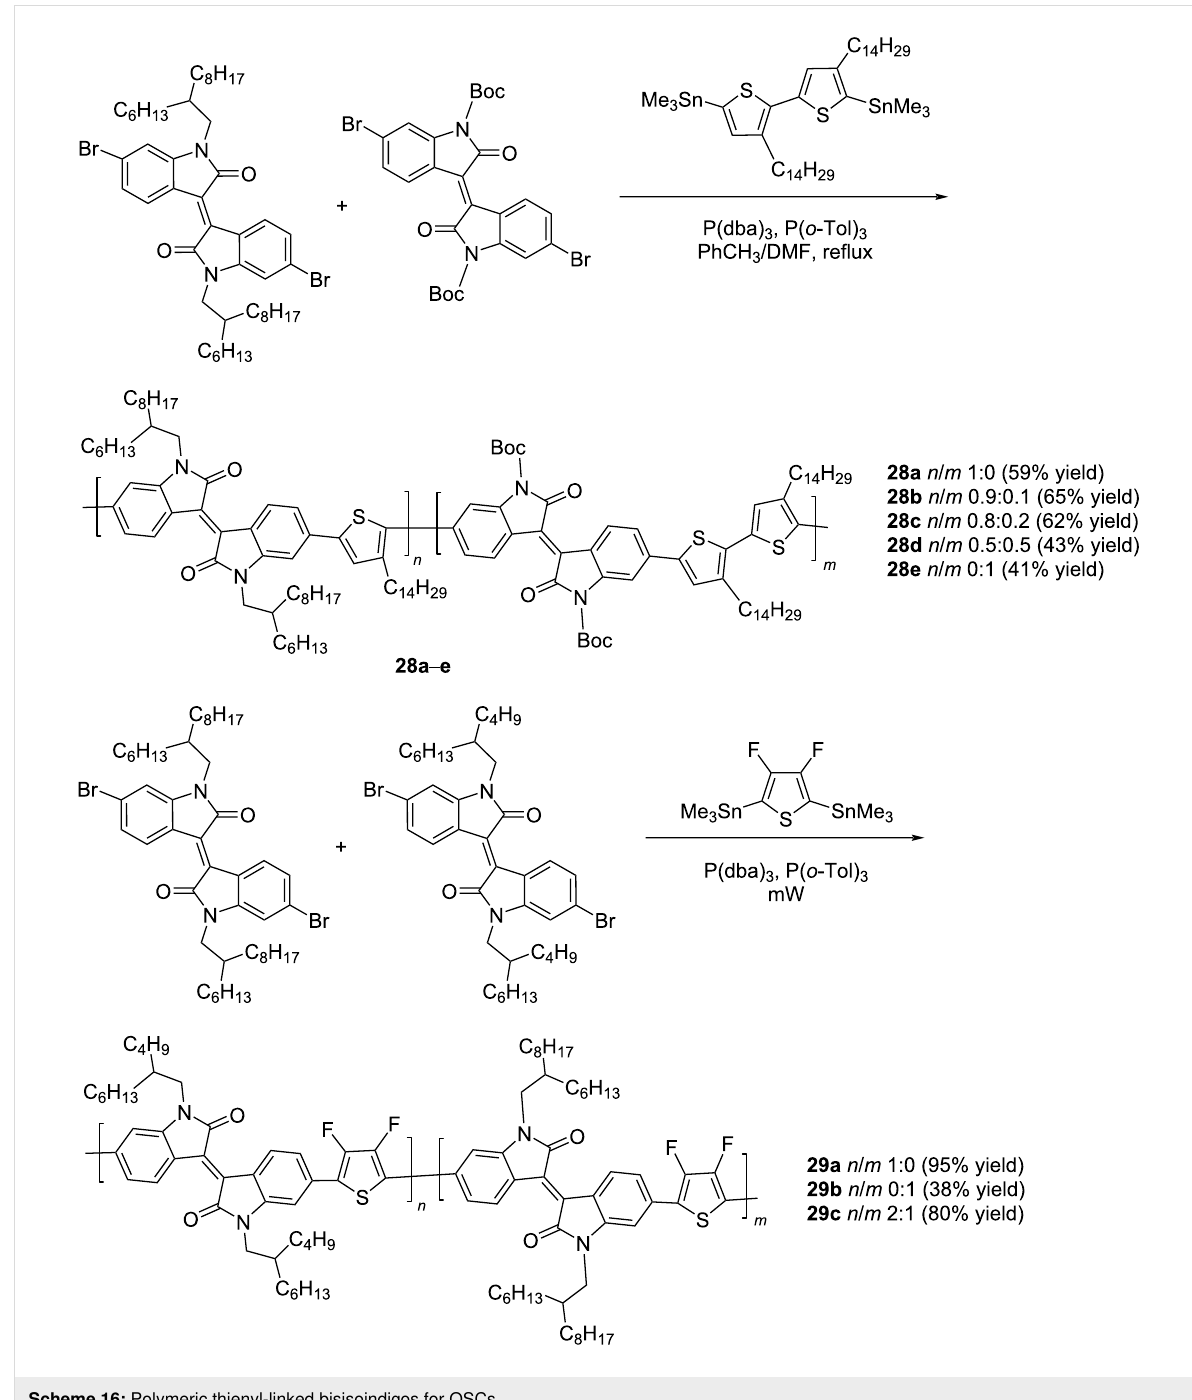
Scheme 16: Polymeric thienyl-linked bisisoindigos for OSCs.